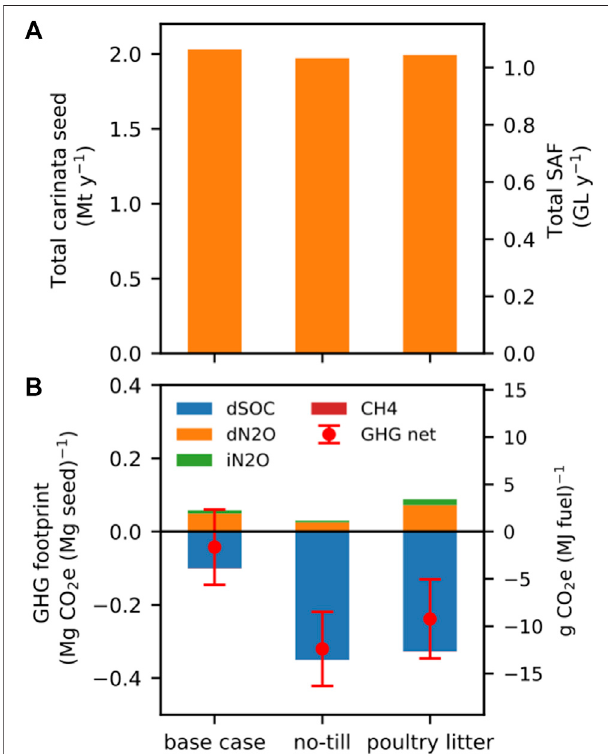
FIGURE 6 | Performance of different carinata management scenarios in terms of (A) total annual seed yield and associated SAF potential from the study region, and (B) the associated soil GHG footprint per Mg of seed production, also expressed in units of global warming intensity (g CO 2 e (MJ fuel) − 1 ) for the resulting carinata – SAF. Red error bars denote ±2SD of fi eld-to- fi eld variability. These results focus on thelocal soil GHGbalanceonly; neitherupstreamemissionsfromnitrogenproductionandfarmoperationsnor the alternate fate of poultry litter are included.